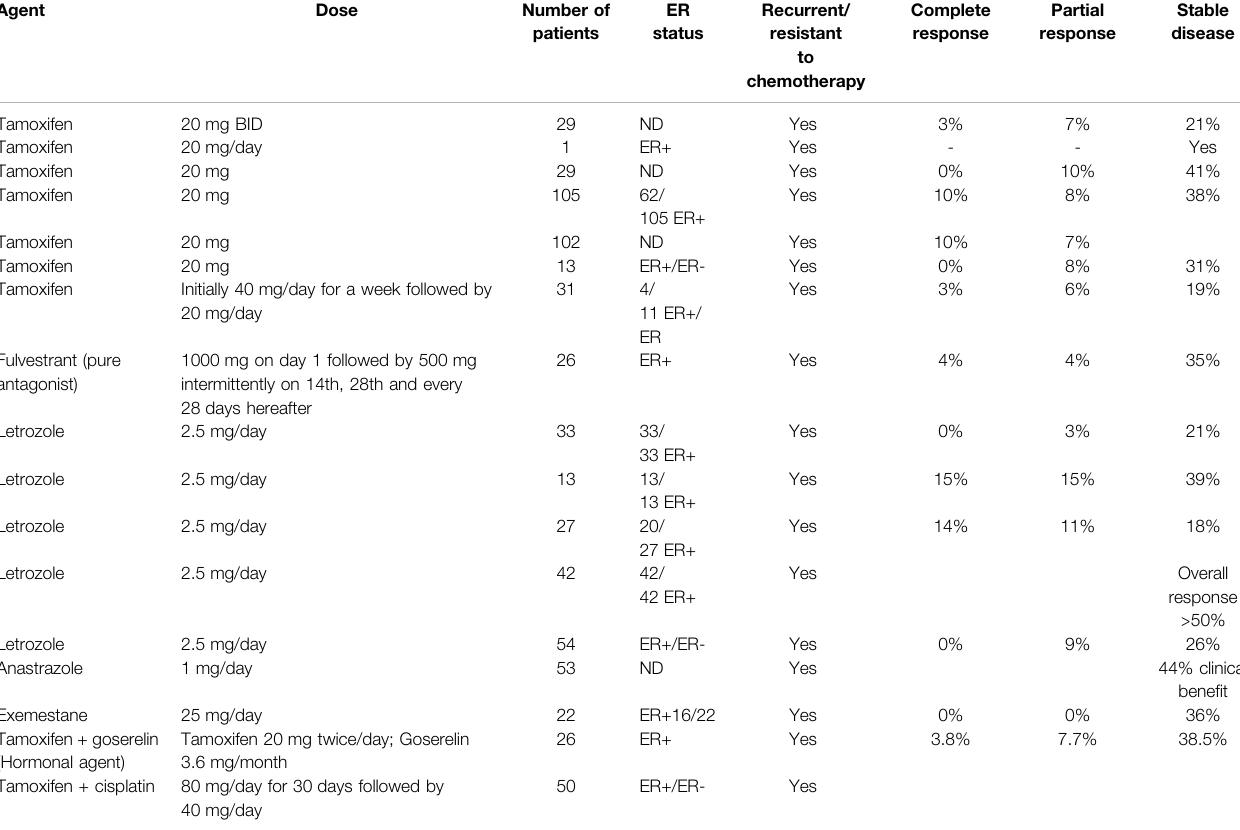
TABLE 1 | Response to the use of antiestrogens and aromatase inhibitors in recurrent ovarian cancer patients administered alone and in combination in the literature.